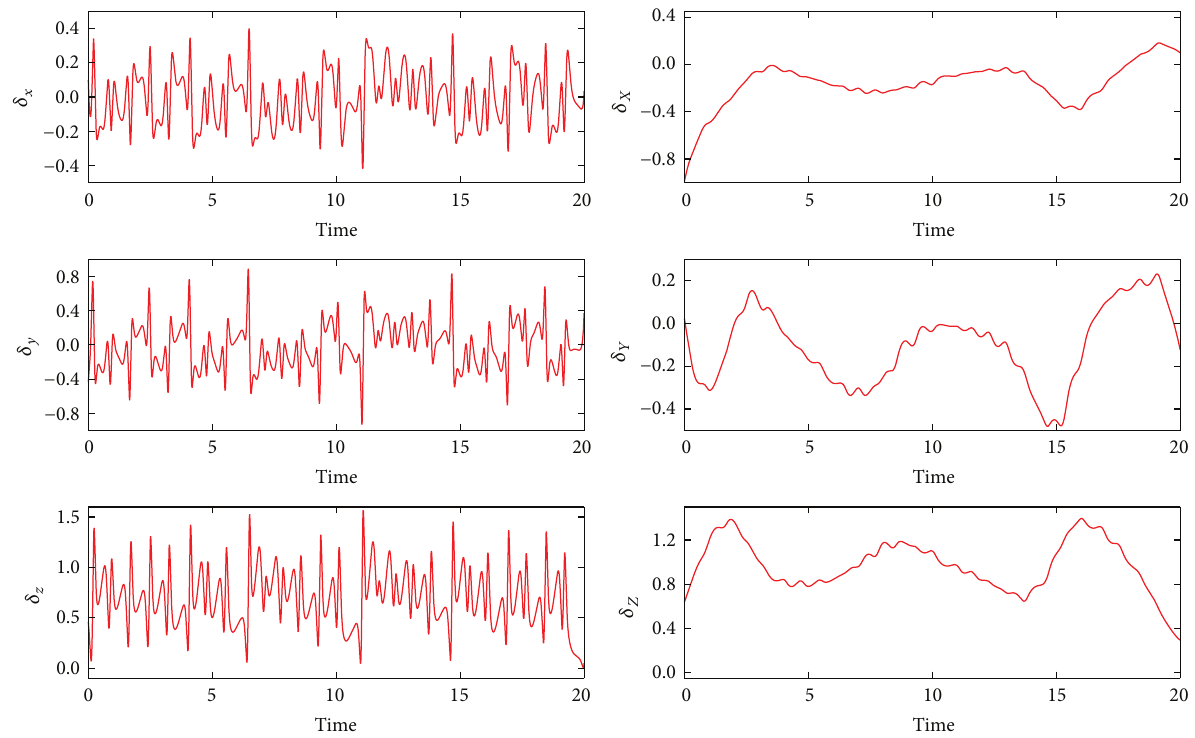
Figure 11: Difference between variables that correspond to the original trajectory and pseudoorbit for 𝑐 0 = 0.01